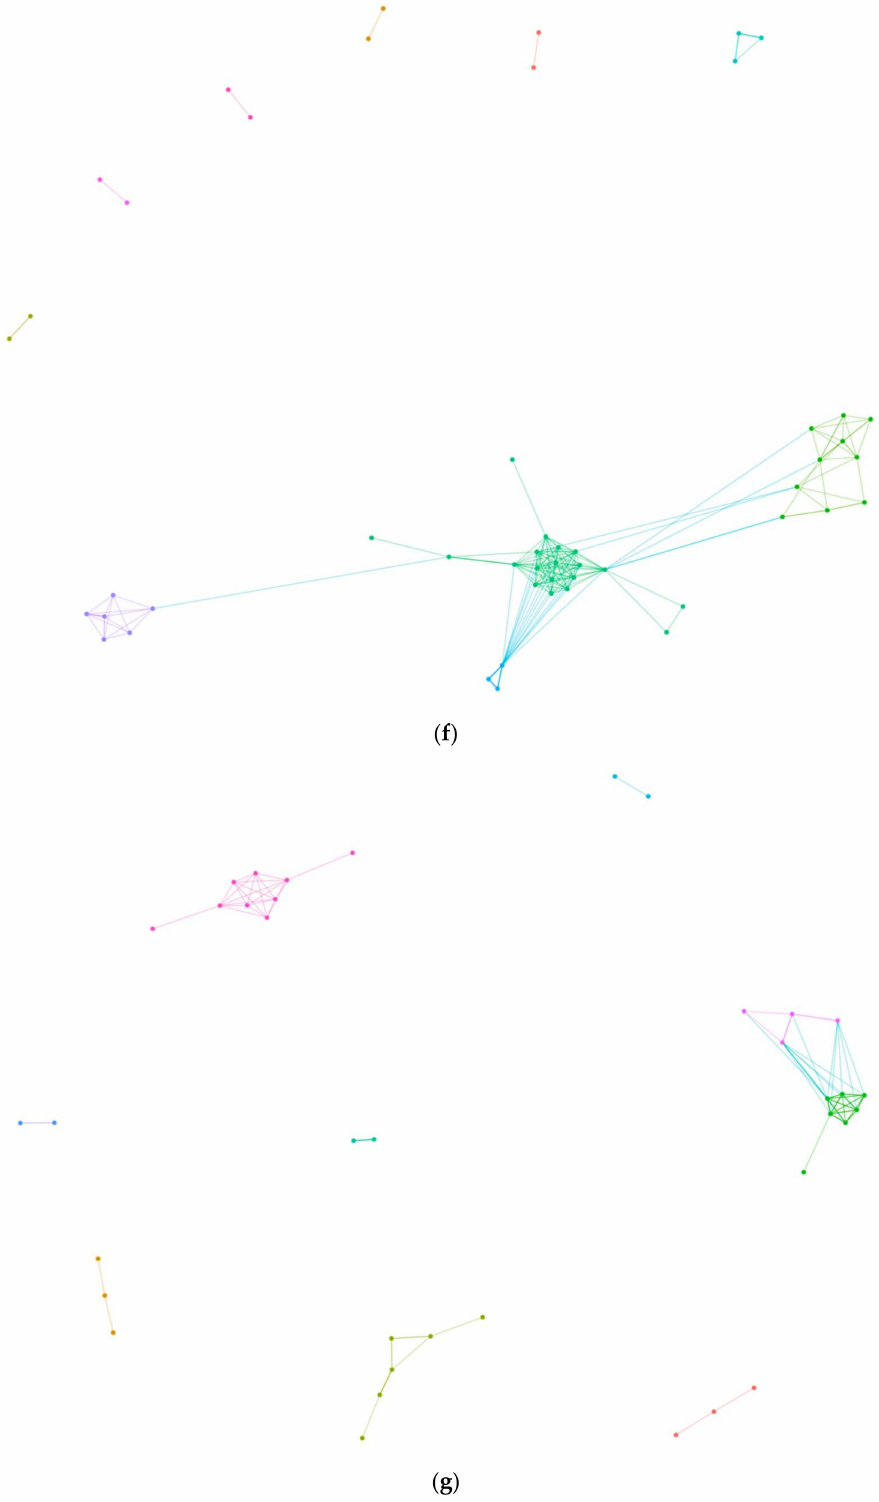
Figure 4. ( a ): Bibliographic coupling graph for 2022. ( b ): Bibliographic coupling graph for 2021. ( c ): Bibliographic coupling graph for 2020. ( d ): Bibliographic coupling graph for 2019. ( e ): Bibli- ographic coupling graph for 2018. ( f ): Bibliographic coupling graph for 2017. ( g ): Bibliographic coupling graph for 2016. Cluster membership is indicated by